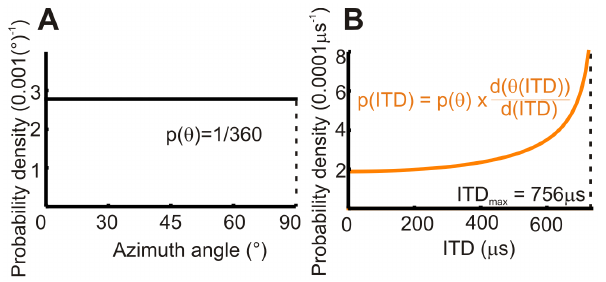
Figure 6. Probability distributions for a sound source in the angular and time domains. Probability distributions in the angular ( A ) and time ( B ) domains for a distant pure tone 500 Hz sound with equal probability of originating at any azimuth angle. This results in a non-constant probability distribution across ITDs, with a greater probability of a sound having a long